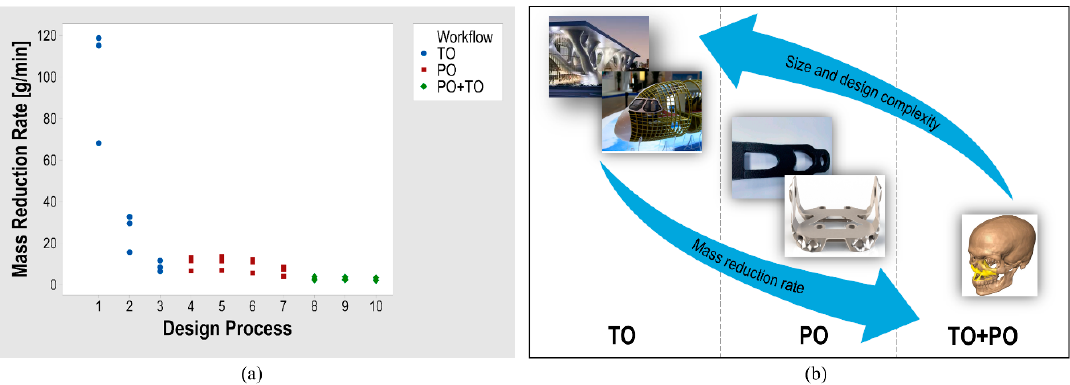
Figure 19. ( a ) The mass reduction in TO, PO, and PO + TO workflows, and ( b ) an illustration of the mass reduction in the three workflows vs. the size and design complexity, as well as typical examples in each workflow.